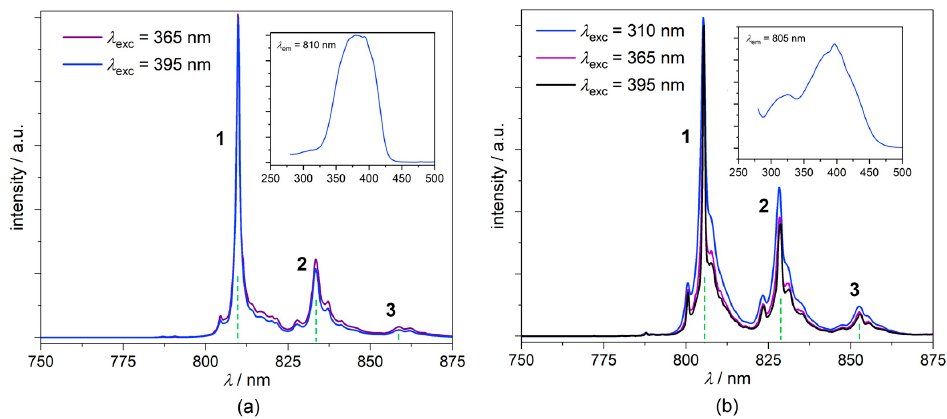
8888 Figure 8. 2 E g → 4 A 2g emission spectra of 1 ( a ) and (PPh 4 ) 3 [Cr(CN) 6 ] · 2H 2 O reference ( b ) at various excitation wavelengths in T = 77 K. The insets show the excitation spectra at λ em related to the highest emission intensity in emission spectra. Table 3. The energy of 2 E g → 4 A 2g phosphorescence bands in 1 and (PPh 4 ) 3 [Cr(CN) 6 ] · 2H 2 O in 77 K, in nm (cm − 1